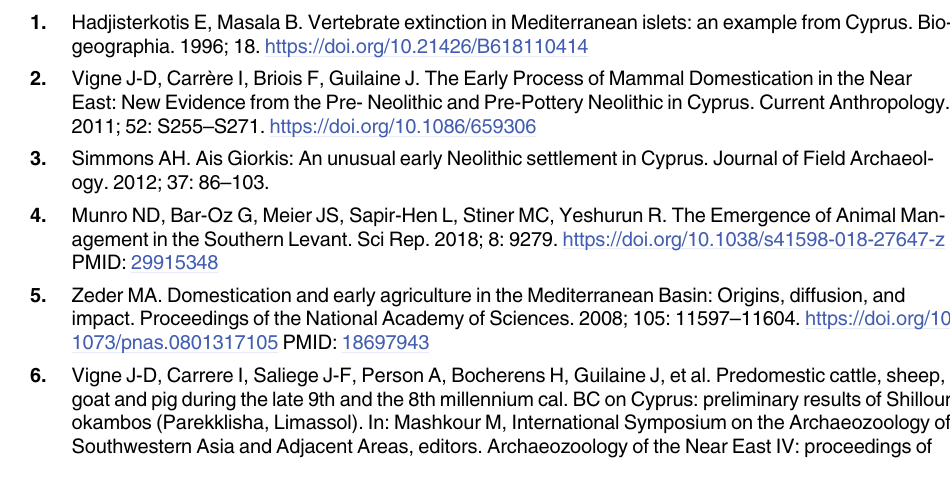
S1 Table. Bone collagen stable isotope data from Politiko- Troullia . S2 Table. Stable isotope data from modern and archaeological